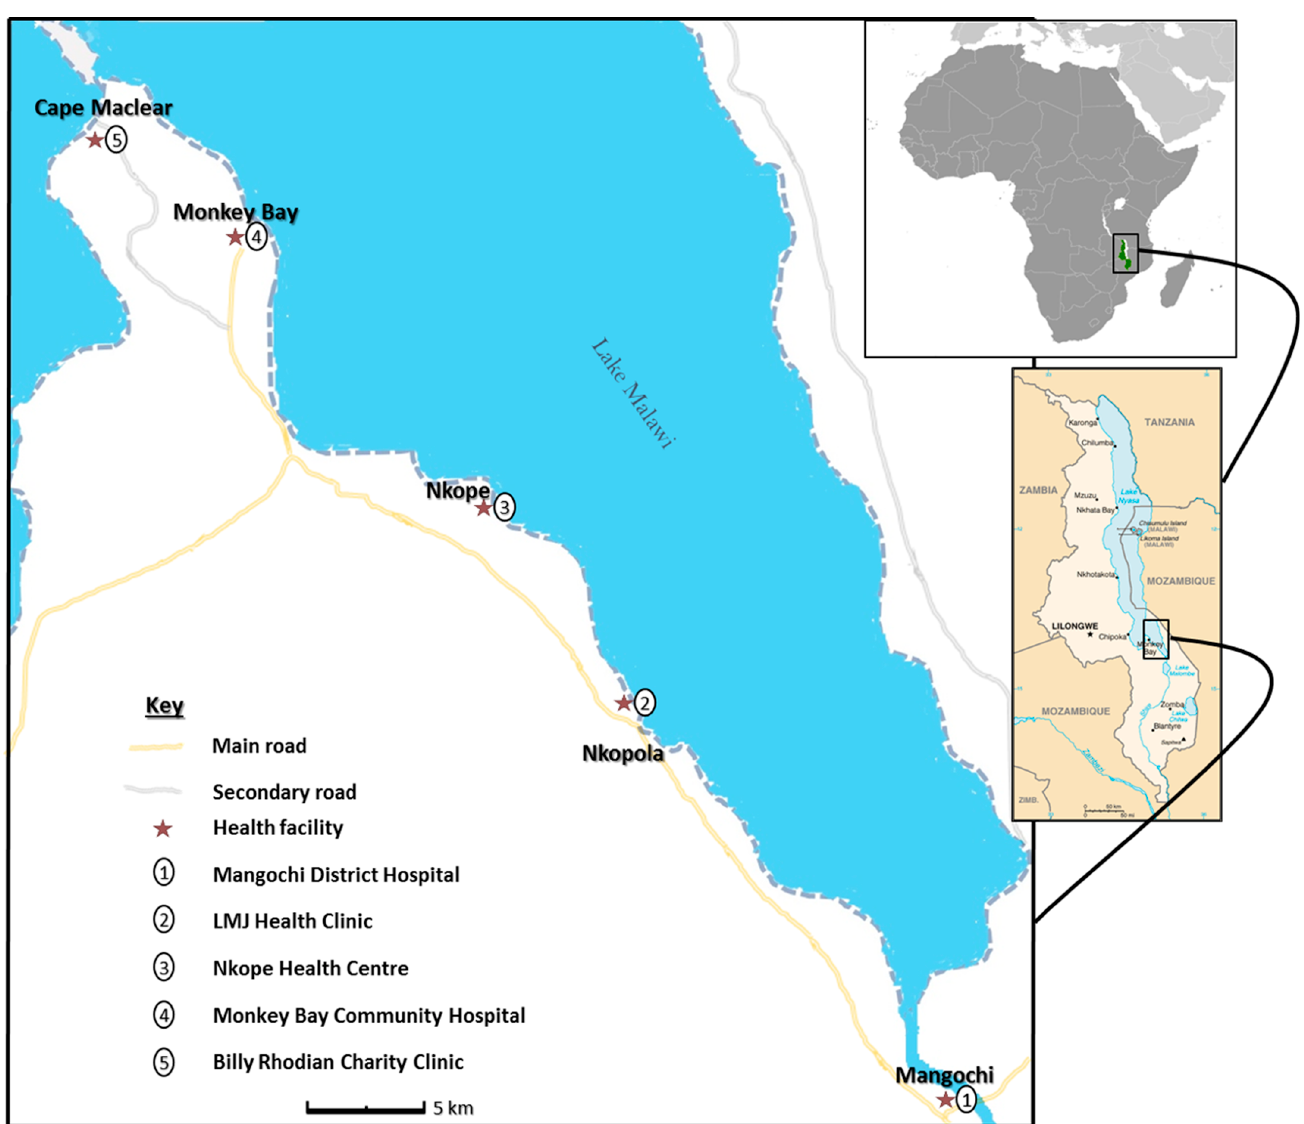
Figure 1. Schematic map of Study area showing health facilities along Lake Malawi. (The study map was produced by Sekeleghe Kayuni (on 4 August 2019), while the maps of Africa and Malawi were reproduced from the maps at the Central Intelligence Agency (CIA) website, public domain: https://www.cia.gov/library/publications/the-world-factbook/attachments/locator-maps/MI-locator-map.gif accessed on 4 August 2019 and https://www.cia.gov/library/publications/the-world-factbook/attachments/maps/MI-map.gif accessed on 4 August 2019).